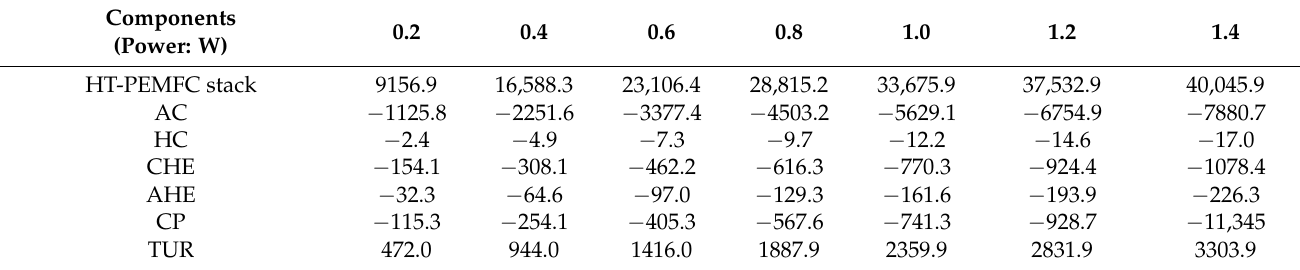
Table 2. Power of each component at different current